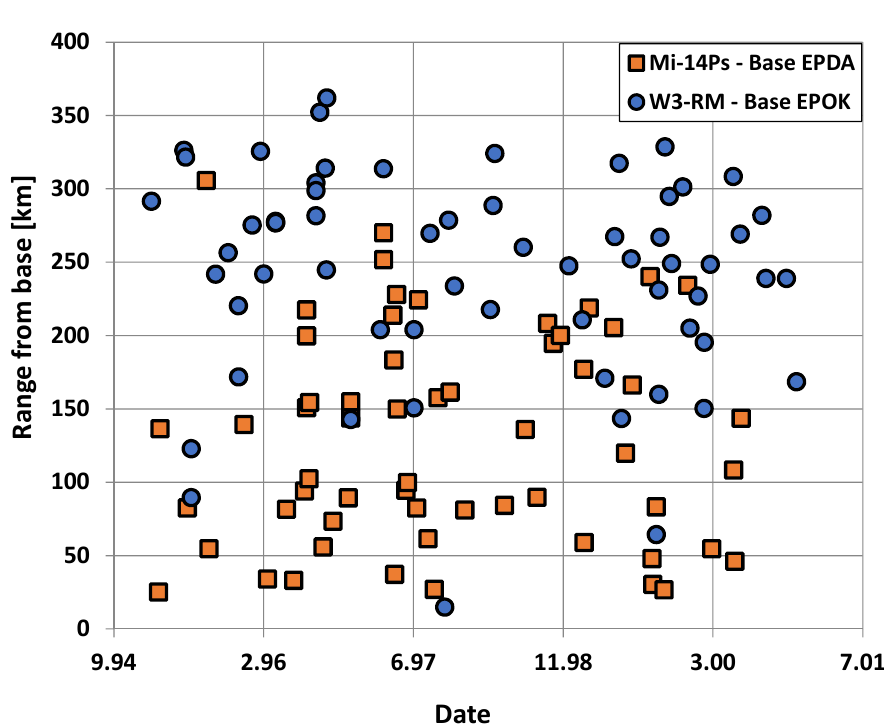
Figure 6. Rescue mission distance from base for missions which started from both EPDA and EPOK bases in years 1995–2001; Mi-14 PS and W3-RM helicopters were used.